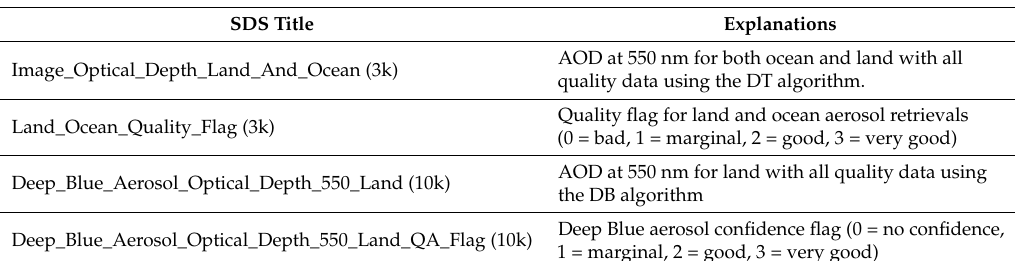
Table 1. Level 2 science data segments (SDS) titles and explanations for Aqua Moderate Resolution Imaging Spectroradiometer (MODIS) aerosol optical depth (AOD). SDS Title Explanations AOD at 550 nm for both ocean and land with all quality data using the DT algorithm.